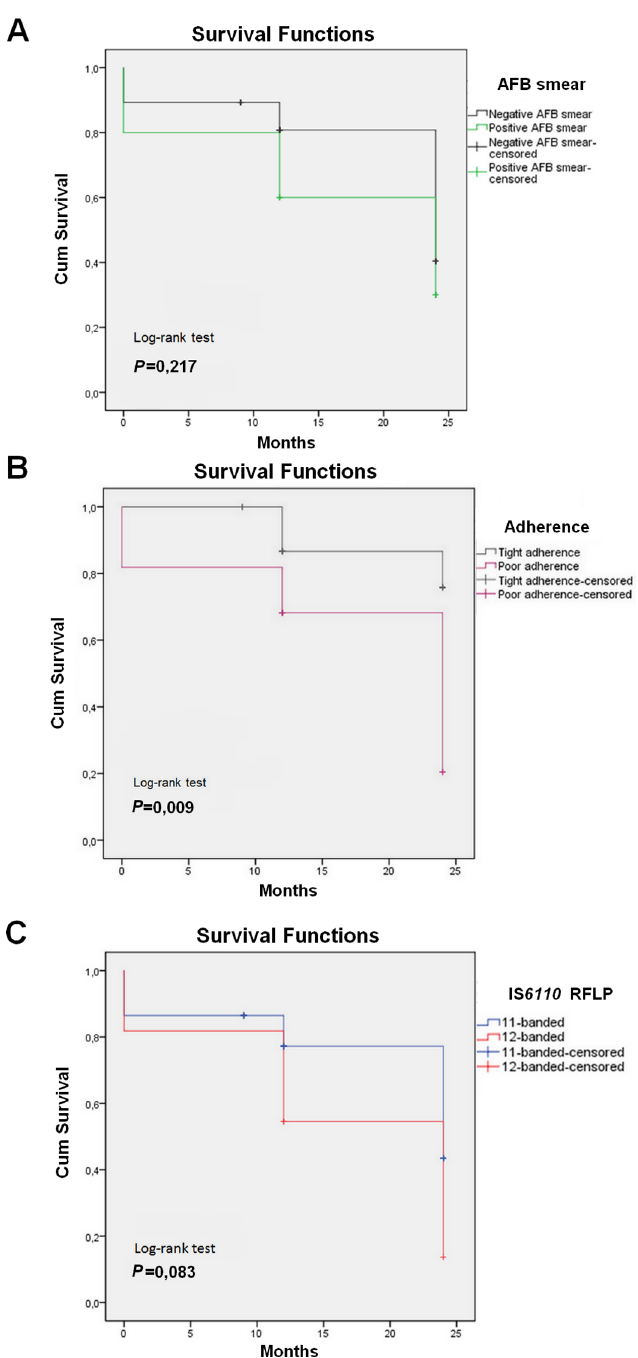
Fig 3. Kaplan – Meier plots and log-rank test for probability of unfavorable outcomes, according to AFP smear positivity (A), poor adherence to treatment (B), and IS 6110 RFLP pattern of the outbreak strain